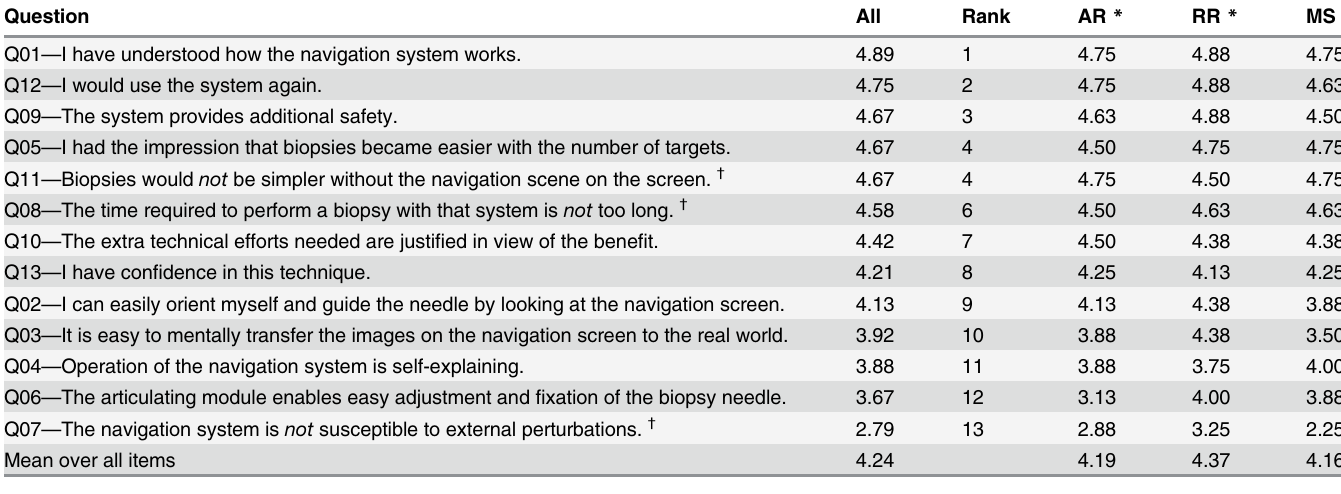
place. The MR table was moved into the scanner, the phantom was imaged with the control sequence (see above) and the table was moved back out for the next biopsy cycle. A biopsy was regarded as diagnostic success if the sample clearly contained green material from the pea (Fig 2). For each simulated biopsy, we recorded the partial times for (i) access planning, (ii) Table 1. Mean Likert item scores on usability and workflow of navigation tool by 24 operators from three groups. Question All Rank AR * RR * MS